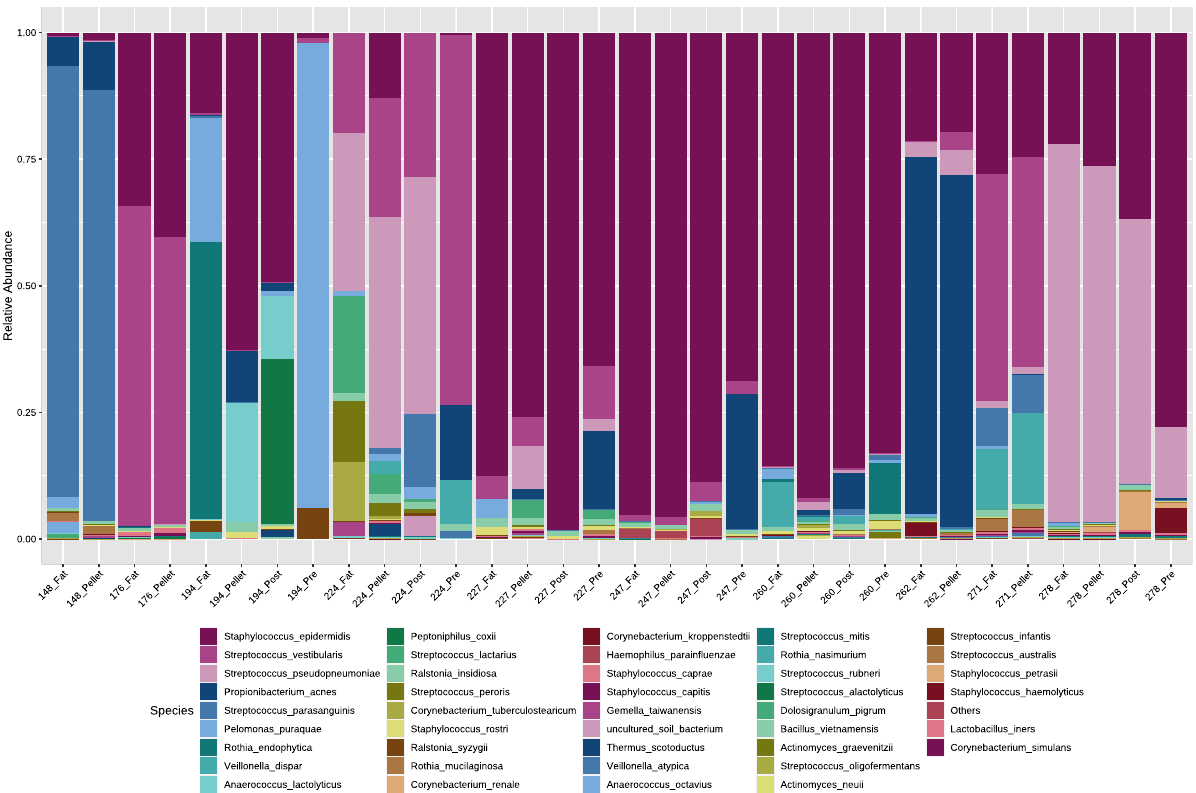
Figure 1. Relative abundance of bacterial species detected in different fractions (fat or cell pellet) of human milk samples (n = 10). For a subset of six mothers, whole milk pre-feed (low fat) and whole milk post-feed (high fat) samples were also available. Data presented here are raw data (i.e. not